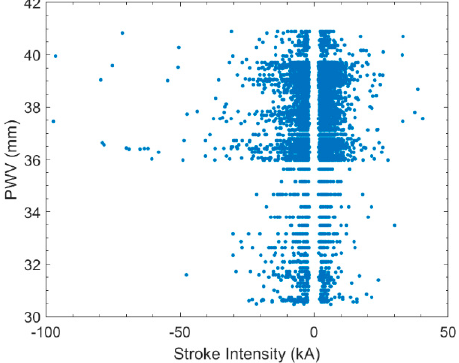
Figure 10. Scatterplot of PWV as a function of strokes intensity.